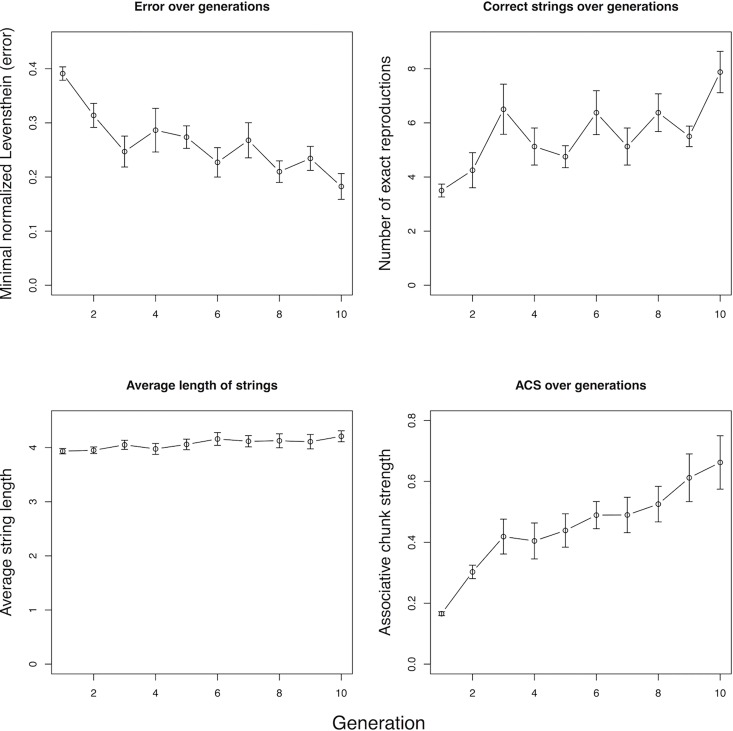
Increase in learnability and distributional structure across generations of learners.Global error decreased across time (top-left). Participants become better at reproducing the string sets (top-right). String sets do not diminish in length across time (bottom-left). Structure increases over generations, as indicated by the mean of Associative Chunk Strength (ACS) of string sets (bottom-right). In all cases, the graphs plot means across all eight chains, with error bars reflecting standard error of the mean.